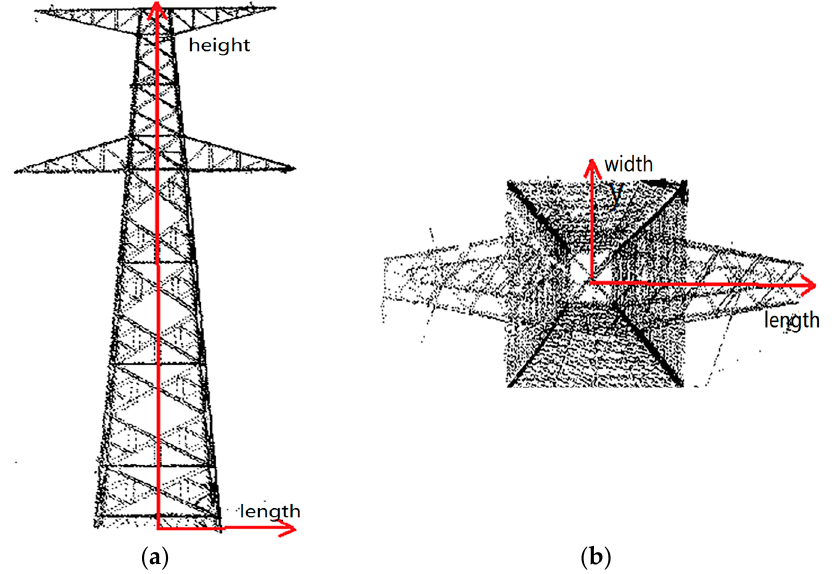
Figure 2. Definition of the 3D pylon coordinate system: ( a ) the front view of a pylon; and ( b ) the vertical view.